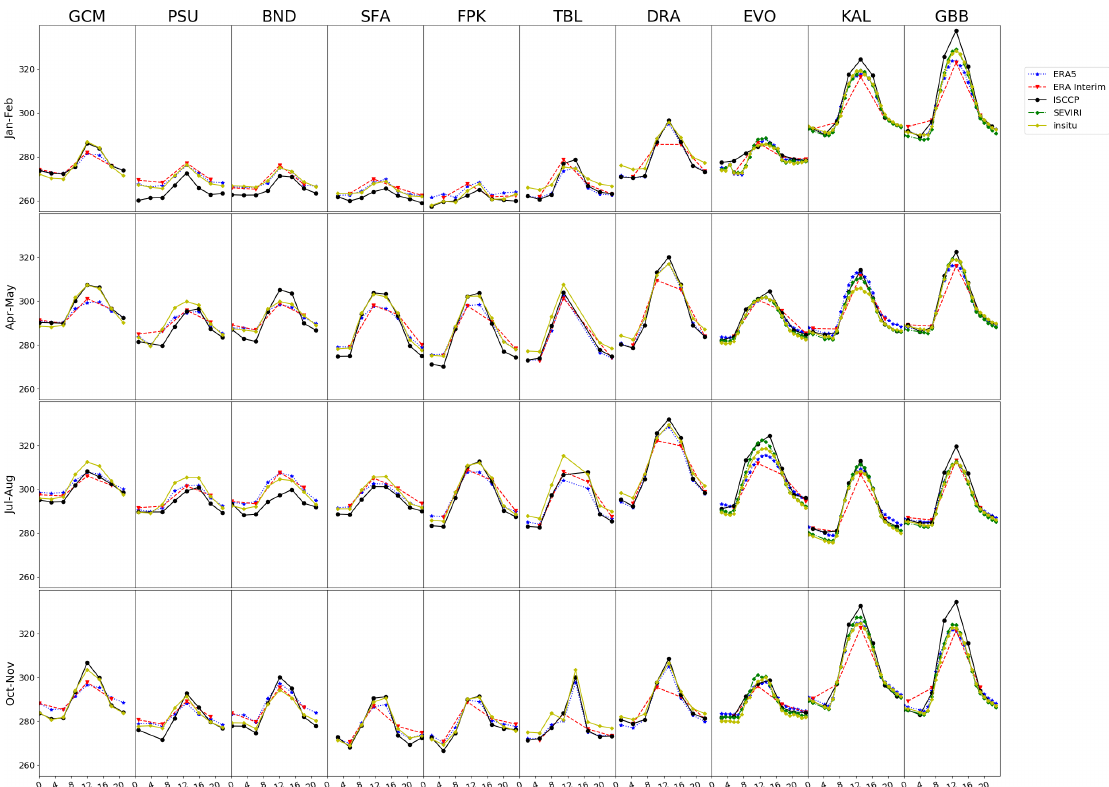
Figure 8. Diurnal variations of monthly mean LST (unit: K) over selected stations, from ERA5, ERA Interim, ISCCP and SEVIRI (when available), and in situ measurements. X -axis represents local